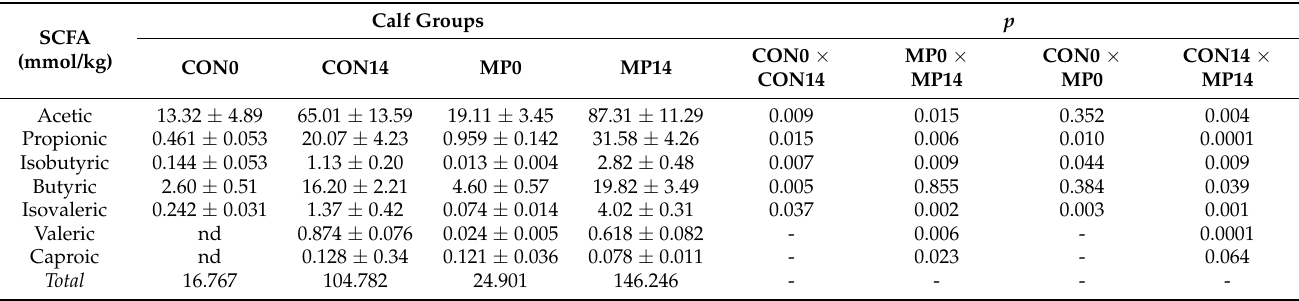
The data are presented as mean ± SE ( n = 10/group). 0, baseline measurements; 14, after 14 days of feeding. nd, not detected. Table 6. Short-chain fatty acids (SCFA) in faeces in the calf group fed with milk replacer only (CON0 and CON14 group) or supplemented with fermented milk permeate (MP0 and MP14